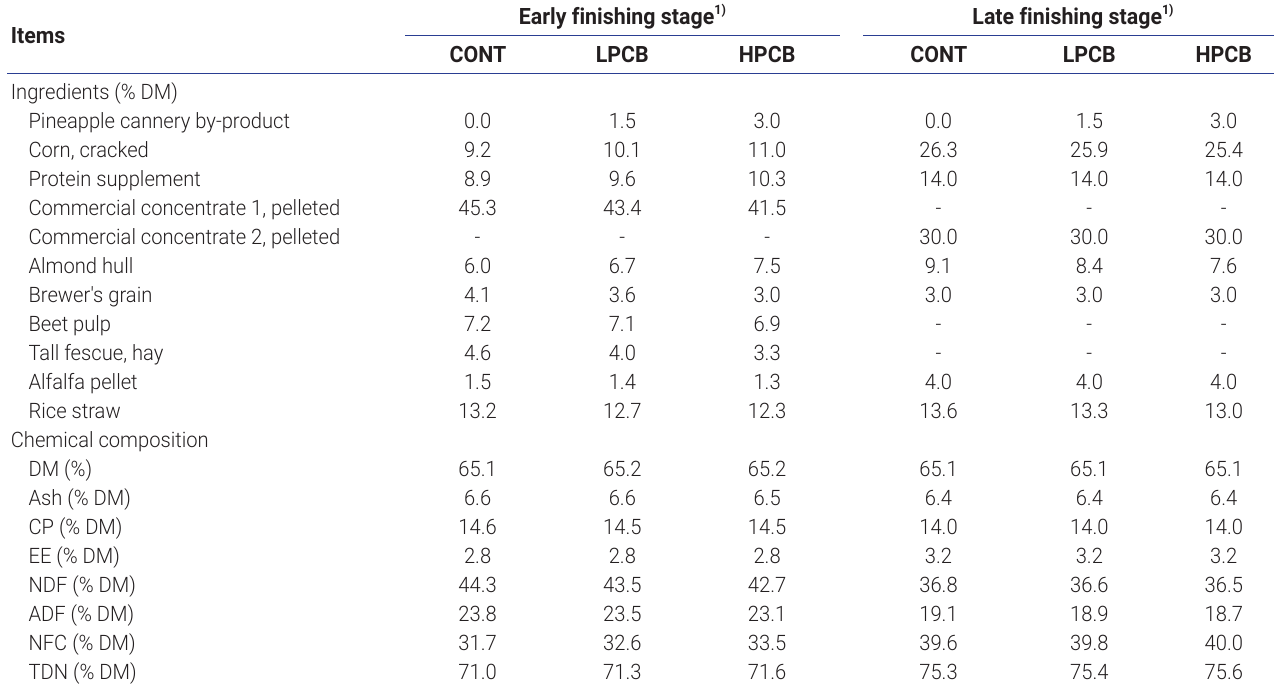
Table 2. Ingredients and chemical composition of experimental